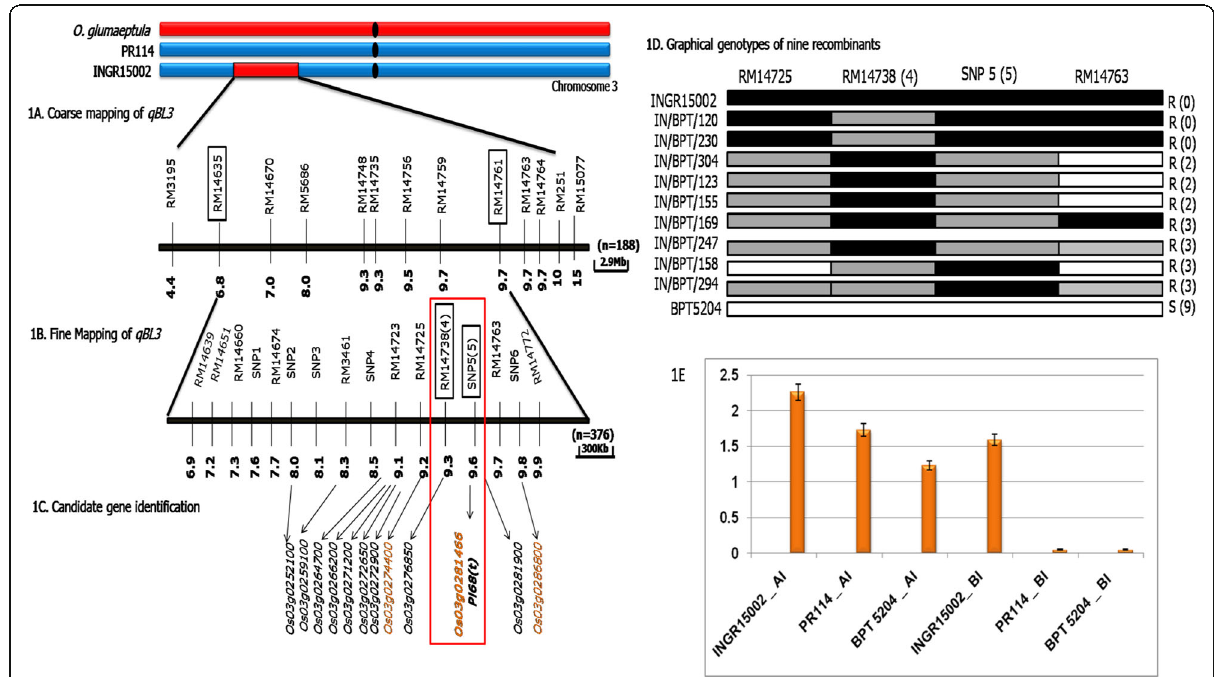
Fig. 1 a The schematic representation of coarse mapped qBL3 region. The markers were arranged based on their physical position in comparison with Nipponbare genome (The physical positions of the markers were retrieved the Gramene – Supplementary table 18 of class I SSRs (https:// archive.gramene.org/markers/microsat/). b The schematic representation of fine mapped qBL3 region. The numbers in parenthesis indicates the number of recombinants. The markers in encircled are the linked markers. c The gene Os03g0281466 within the fine mapped region which is up- regulated in microarray based transcriptome studies and validated through q PCR. Of the 12 up regulated genes in microarray, only three genes are consistent with q PCR (indicated by Red color). The gene Os03g0281466 is the only gene which is up-regulated in both microarray and q PCR and is falling with in the fine mapped region of qBL3 . d Graphical genotypes of recombinants for the markers RM14738 and SNP5. R- resistant; S - Susceptible. The number in parenthesis is the phenotype score in SES (0 – 9) scale. The number on the left are the plant entry number. e Bar graph demonstrating the fold change difference in Os03g0281466 which is induced in INGR15002 upon pathogen infection in q